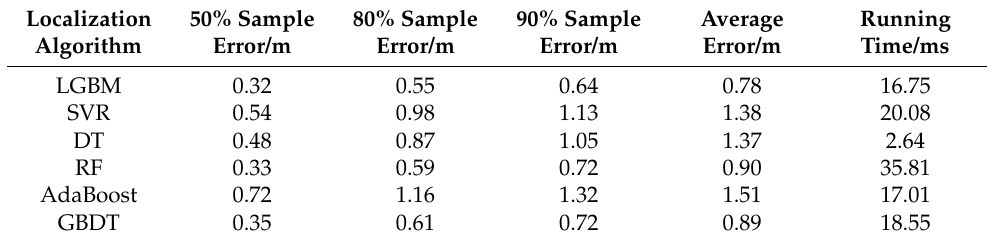
Table 3. Comparison of average positioning errors and running times of the six algorithms.